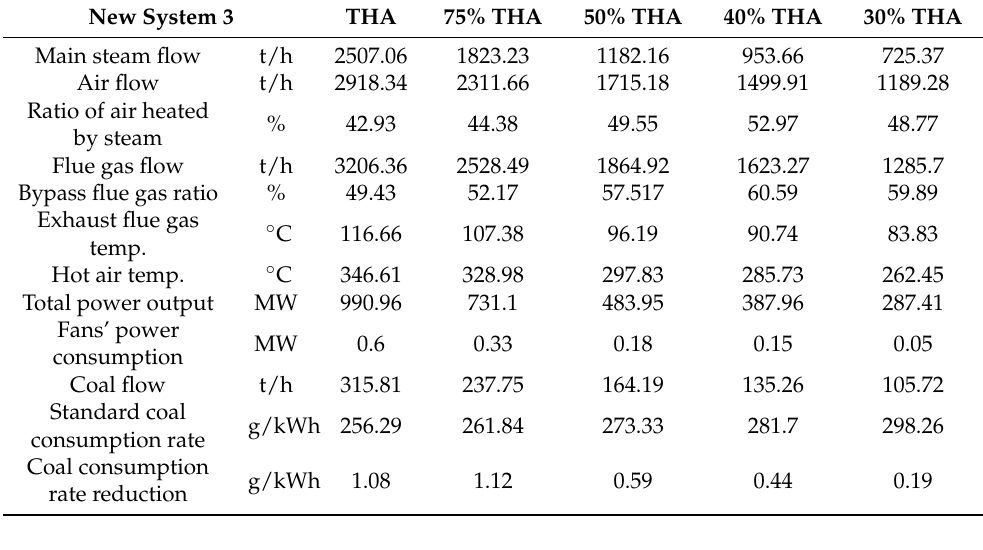
Table 5. Analysis of main parameters under variable parameters.